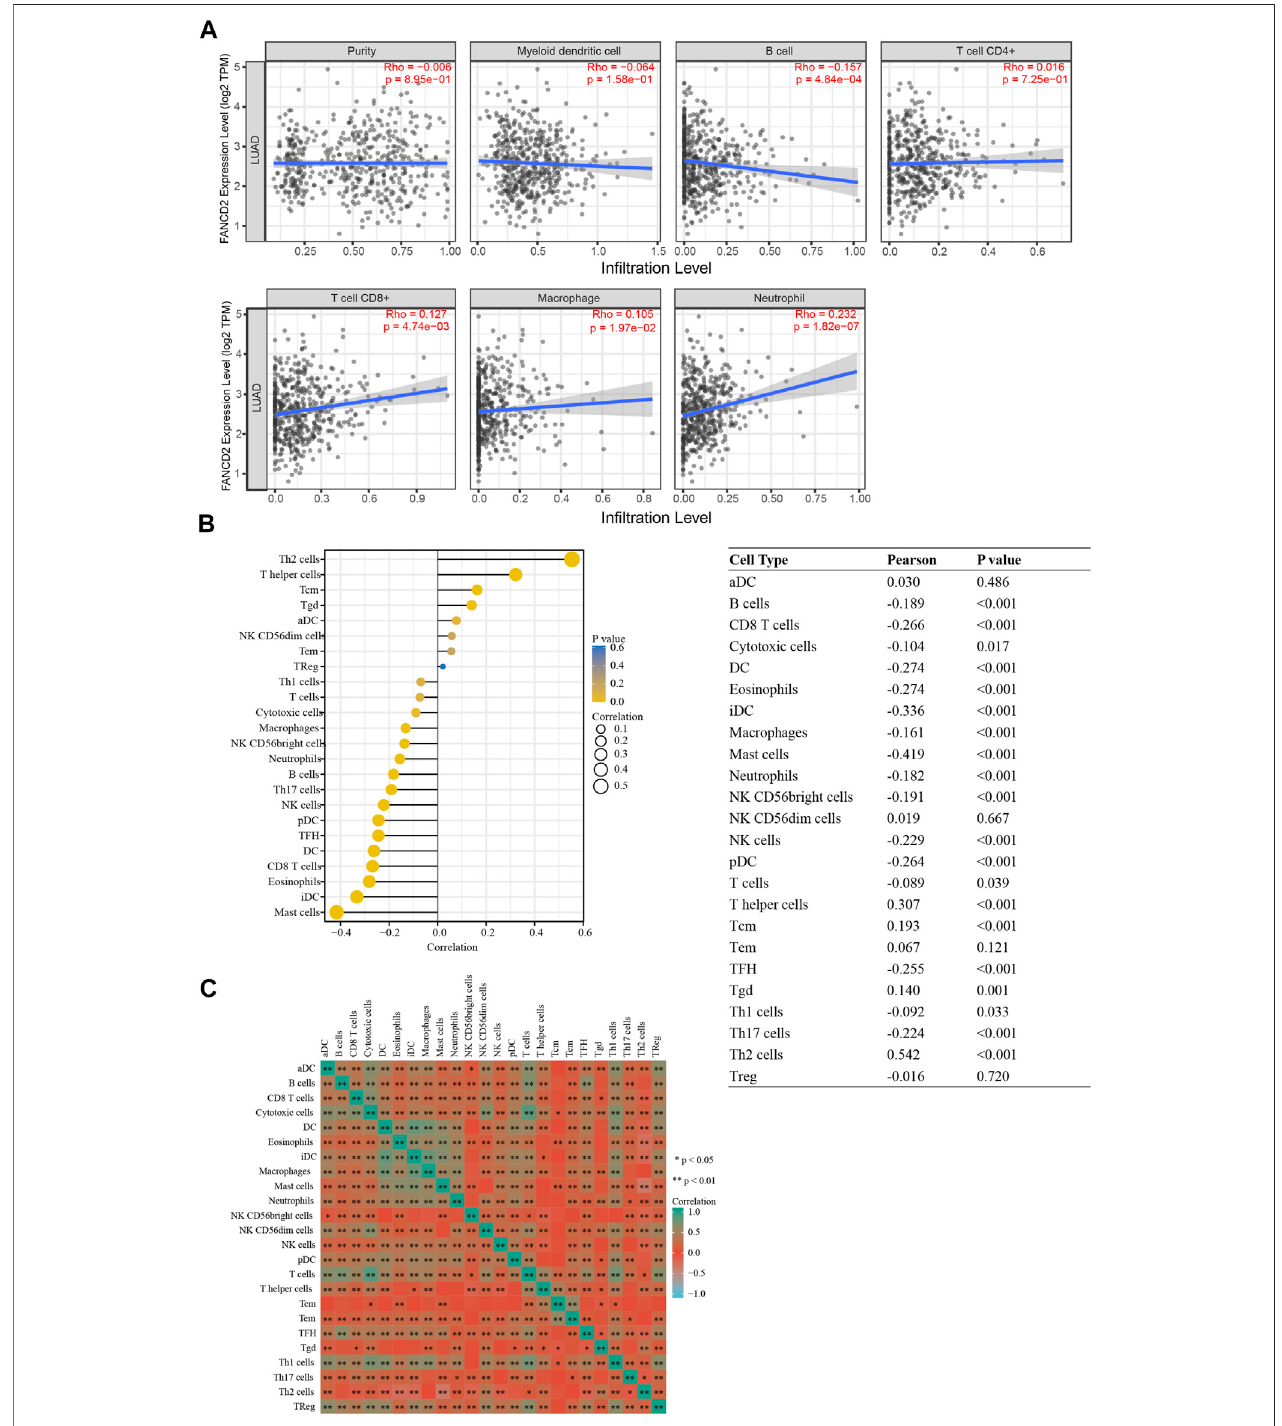
FIGURE 9 | Correlation between FANCD2 expression and immune in fi ltration levels in LUAD. (A) Correlation analysis of FANCD2 expression and the in fi ltration of six types of immune cells based on TIMER. (B) Forest plots show that FANCD2 expression was positively correlated with 8 types of immune cells and negatively correlated with 16 subsets of immune cells. The sizes of dots represent the absolute value of Pearson r. (C) Heatmap showing the relationship among 24 types of immune cells in LUAD. * p < 0.05, ** p < 0.01.